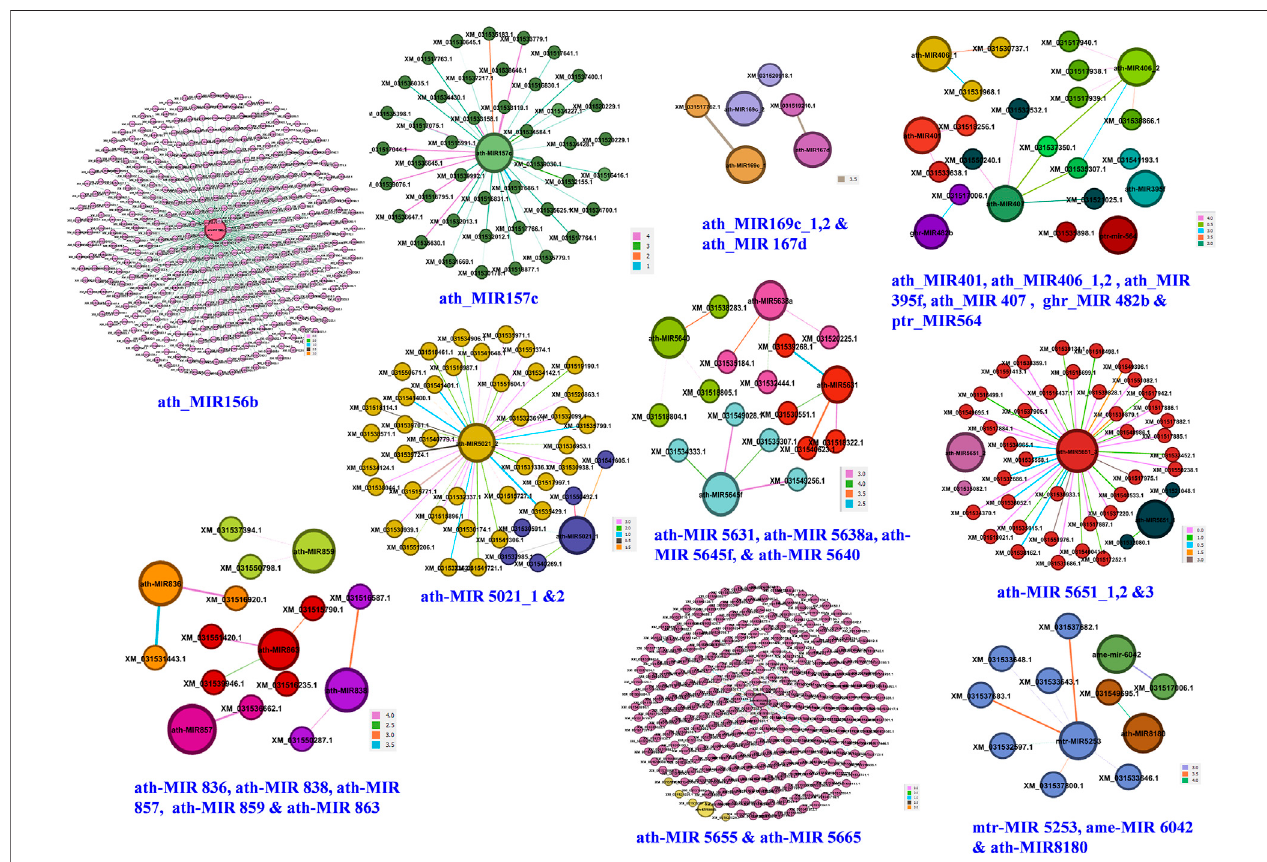
FIGURE 6 | Dendrogram showing the genetic relationships among 16 pomegranate genotypes based on ten MIR_SH_SSR markers.